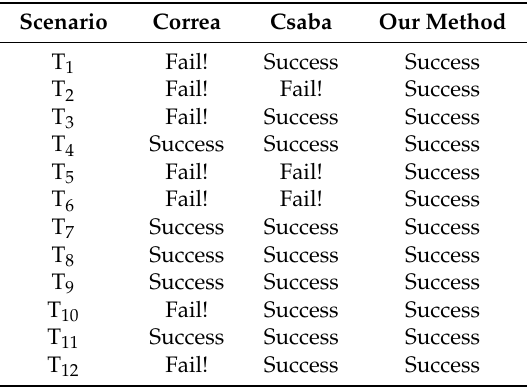
Table 5. Comparisons between Correa, Csaba, and our proposed method on T 1 –T 17 scenarios.